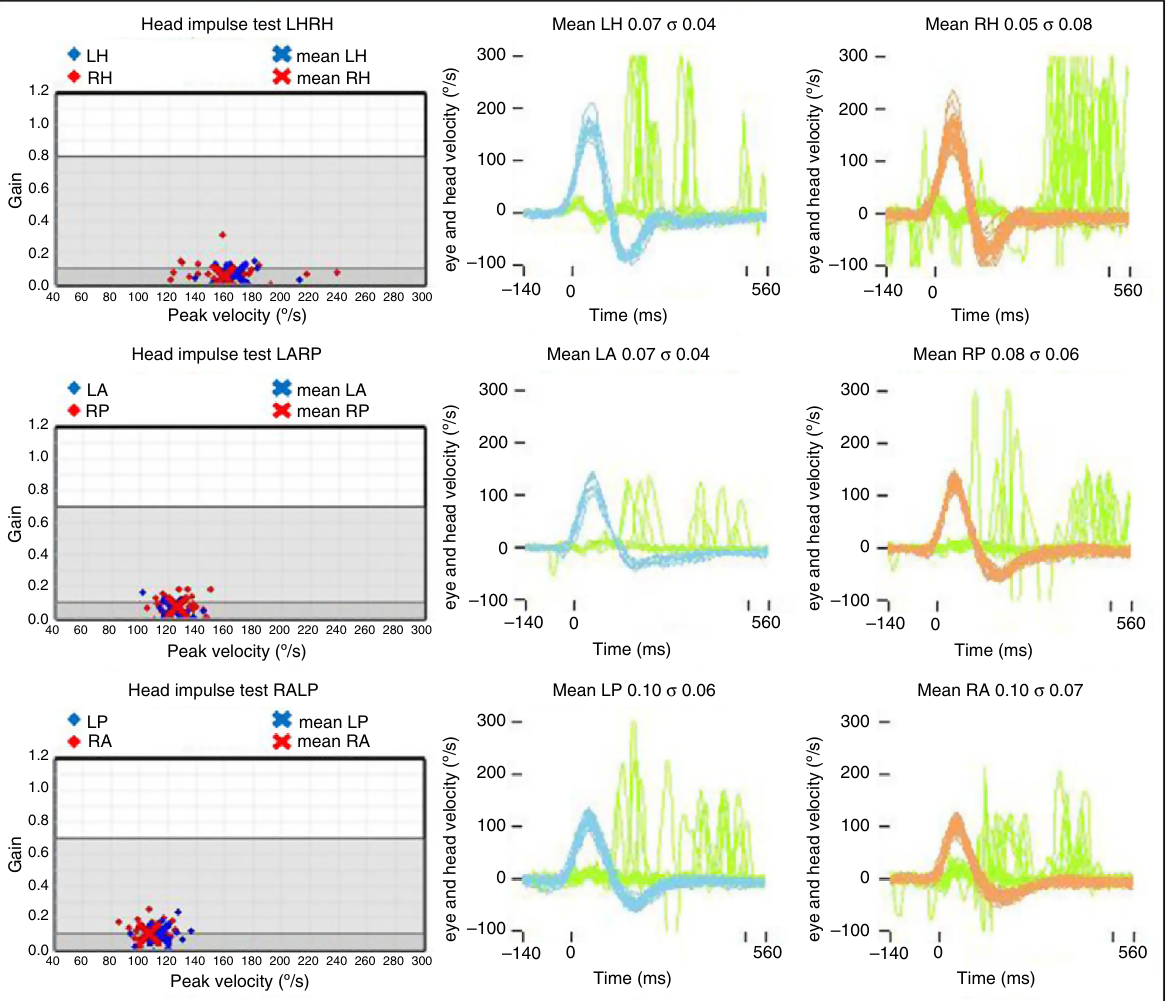
Figure 2 Video head impulse test (vHIT) with an ICS Video-oculographic system (GN Otometrics A/S --- Denmark) for all semicircular canals (LH: left horizontal, RH: right horizontal, LA: left anterior, RP: right posterior, LP: left posterior, RA: right anterior). Passive, unpredictable 5 ◦ ---20 ◦ , 50 ◦ ---250 ◦ /s, and 750 ◦ ---5000 ◦ /s 2 head impulses were delivered manually on the plane of the horizontal and vertical canals while the patient was asked to keep looking at an earth-fixed target. On the right, blue lines represent head impulses exciting left canals, red lines correspond to head impulses exciting right canals, and green lines represent eye movements induced by the activation of the vestibulo-ocular reflex (VOR) following each head impulse. For each canal, the corresponding mean value of VOR gains with related standard deviation ( (cid:2) ) is reported. Overt saccades can be easily detected. On the left, each dot represents the VOR gain (eye velocity/head velocity) for each impulse. VOR showed to be extremely deficient for all canals.